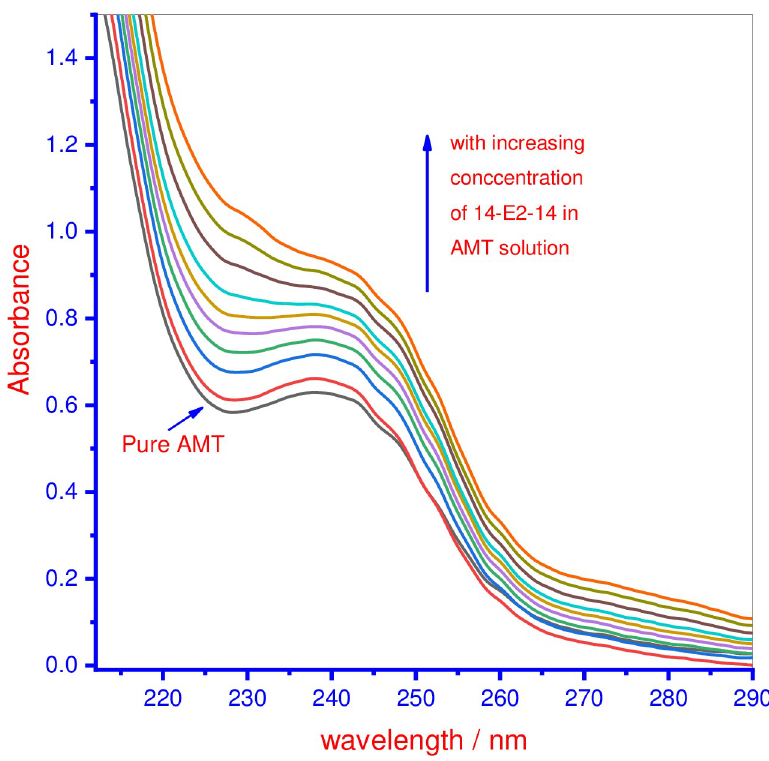
Fig 4. UV-visible spectra of AMT in absence and presence of increasing concentrations of 14-E2-14.